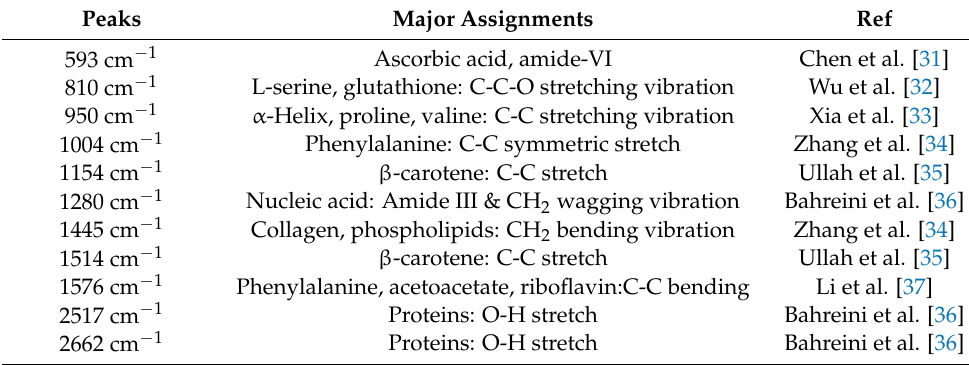
Figure 4. Mean intensities and standard deviations of the main Raman peaks. Table 1. The assignments of Raman peak in the serum spectra.